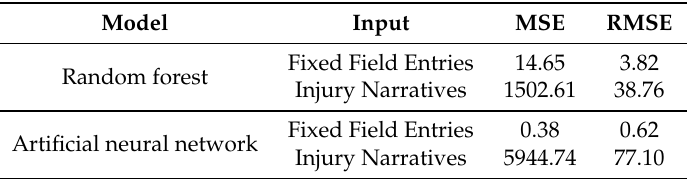
Table 4. MSE and RMSE for all the models.